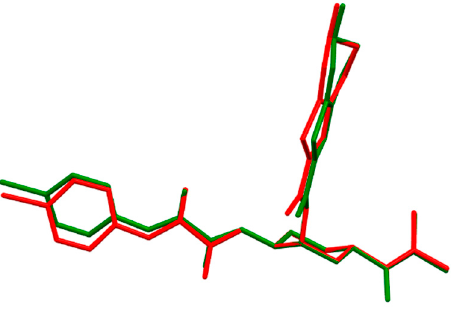
Figure 2. Molecular superimposition of the Becke3LYP optimized molecular structure of edoxaban ( green ) and hydrated edoxaban ( red ). For simplicity the hydrogen atoms are omitted.